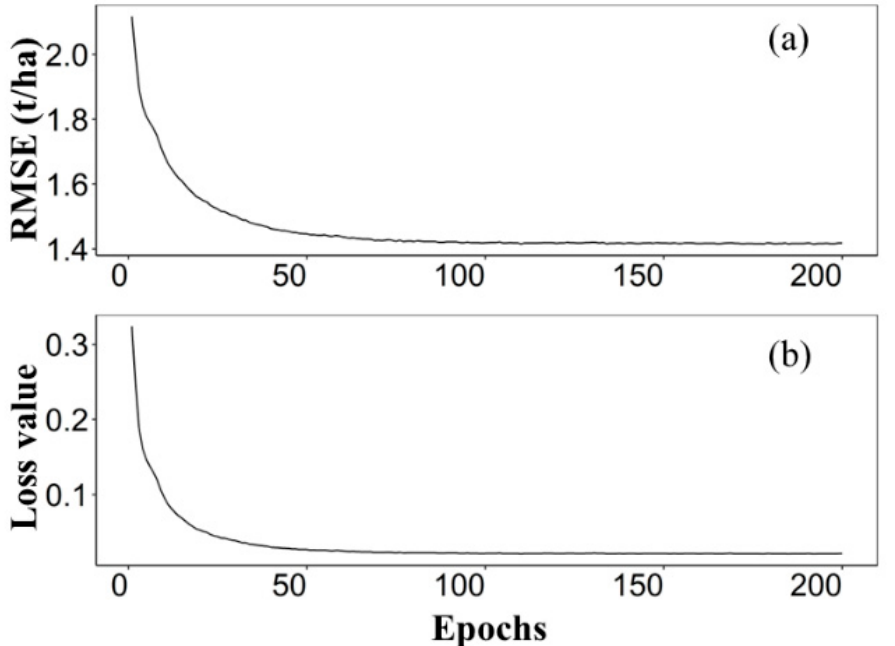
Figure 6. Performances of yield estimation model built using possible dataset and DNN: ( a ) RMSE, ( b ) loss value. RMSE, DNN and epochs represent root mean square error, the deep neural network and DNN iteration number, respectively.